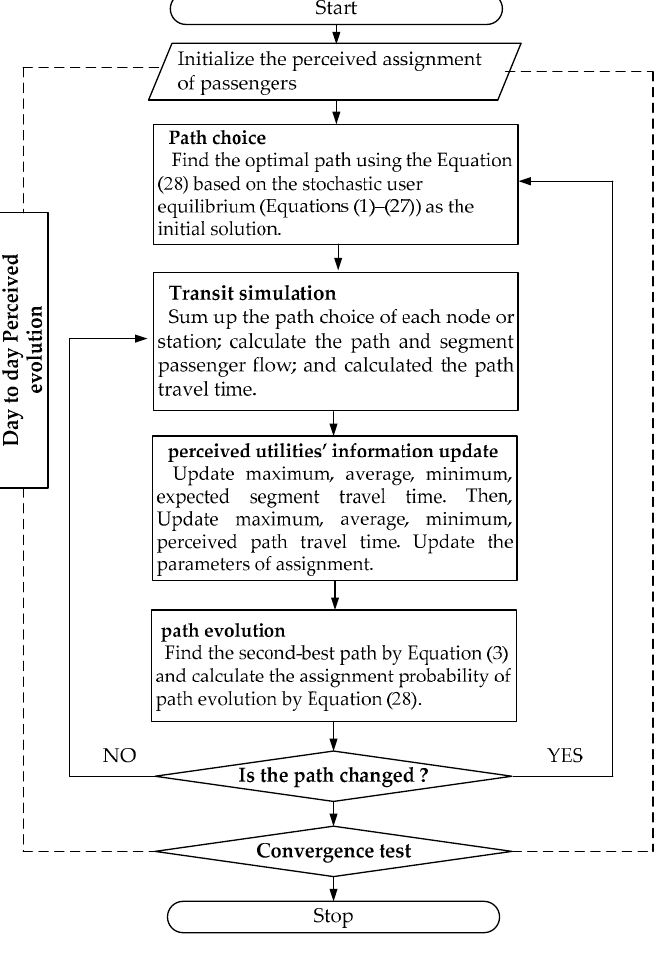
Figure 3 . Solution algorithm. Figure 3. Solution